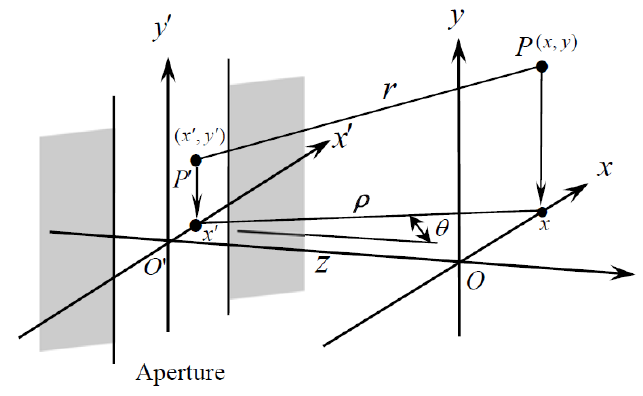
Figure 1. The experimental procedures of this study.